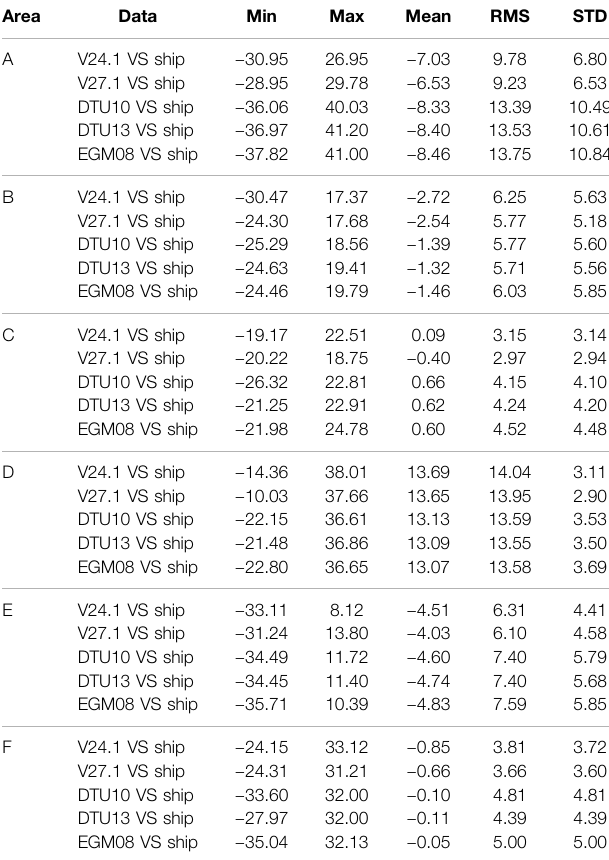
TABLE 6 | Comparison between marine gravity models and shipboard data over different areas in the coastal region of China, unit: mGal. Area